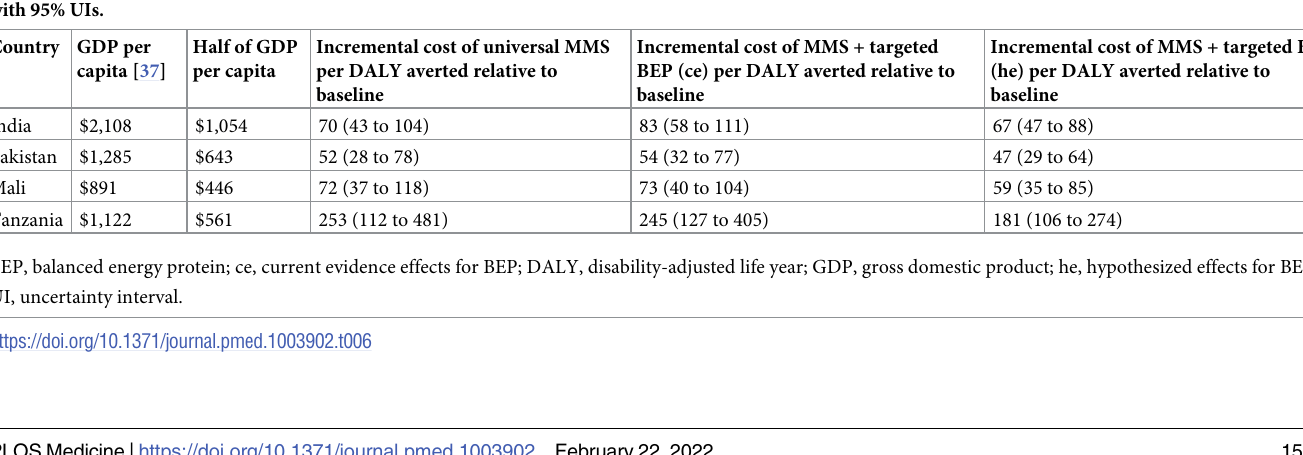
Table 6. GDP per capita and cost-effectiveness thresholds in 2020 USD with simulated cost-effectiveness ratios in 2021 USD per DALY averted relative to baseline with 95% UIs. Country GDP per Half of GDP capita [37] per capita baseline baseline baseline